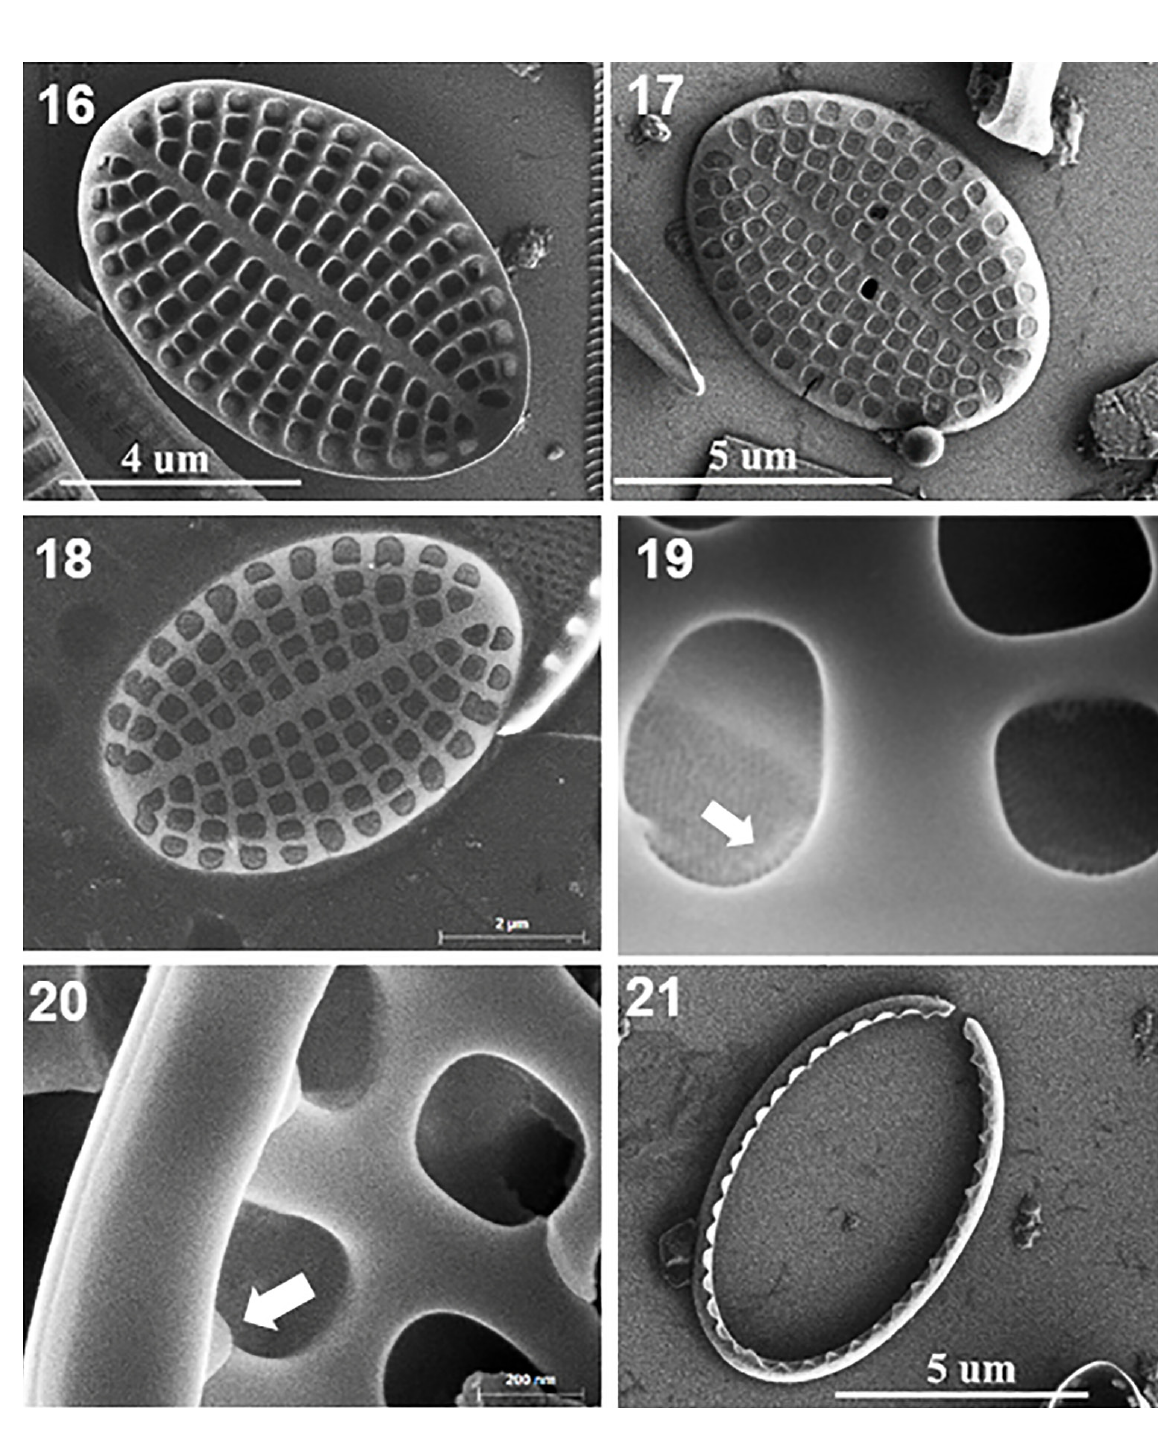
Figs 16–21. SEM images of C. magnoareolata Al-Handal, Riaux-Gob., R.Jahn & A.K.Wulff sp. nov. (BGBM, slide B 40 0043104). 16. Internal view of the SV. 17-18 . External view of the SV, showing subquadrangular areolae. 19 . Hymenes of the SV arranged as slits on the margin of the areolae (arrows). 20 . Abvalvar side of the SV valvocopulae with short fimbriae (arrow). 21 . Open valvocopulae of the SV with numerous serrate